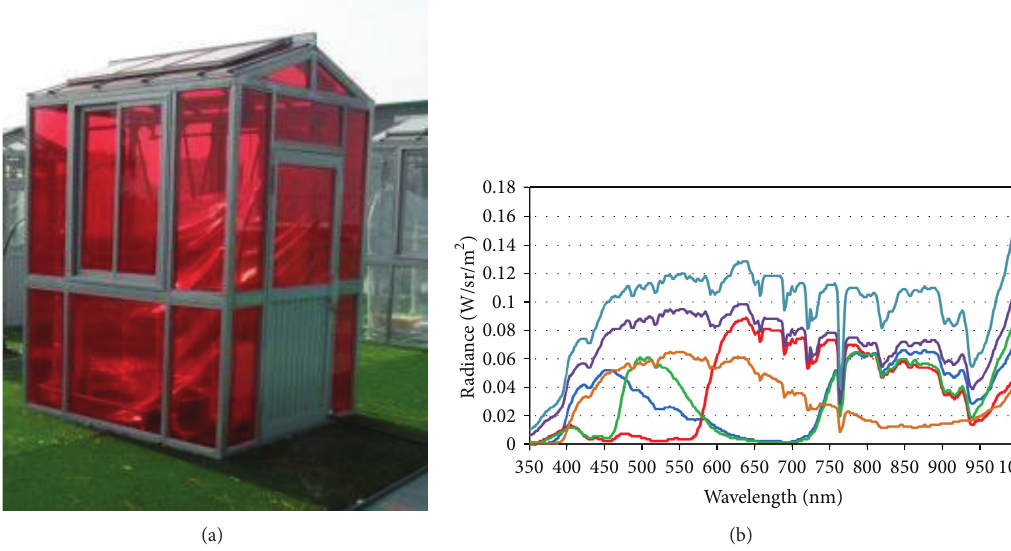
Figure 2: Greenhouse of plant growth and transmittance spectra under solar light (out greenhouse, dark cyan line), solar light (in greenhouse, purple line), IR cladding material (brown line), green cladding material (green line), blue cladding material (blue line), and red cladding material (red line).